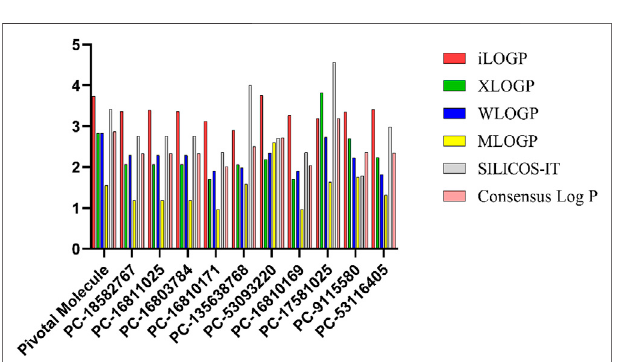
FIGURE 12 | logS values predicted using different methodologies for pivotal molecule and 10 promising compounds. Pivotal molecule: Roc-A; PC: PubChem.